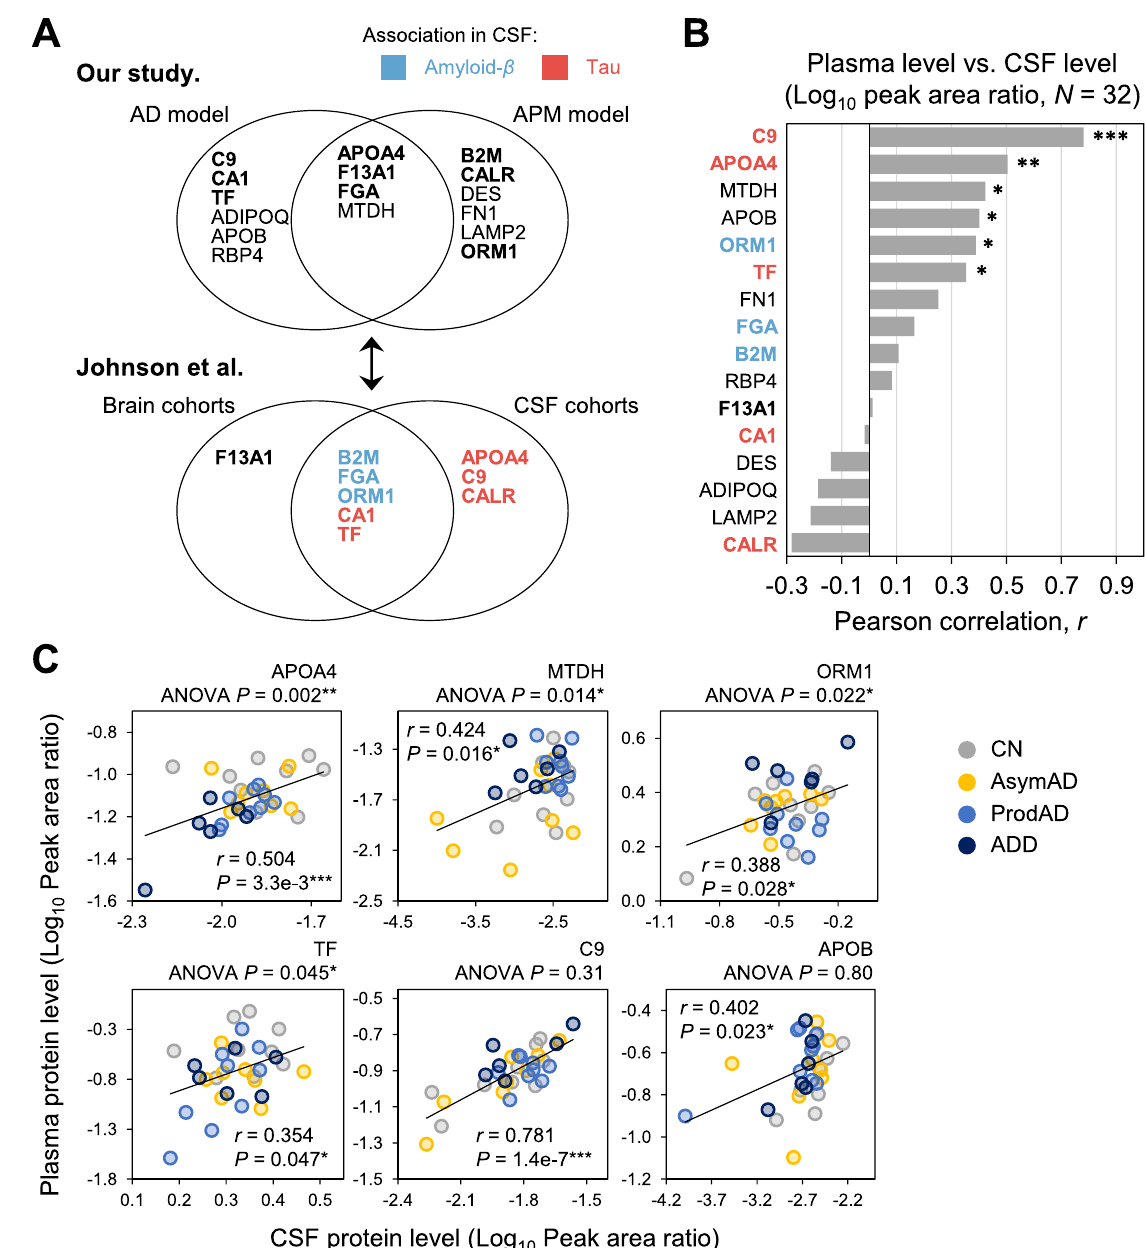
Figure 5. Association of plasma proteins with CSF proteins. ( a ) Correlation between Johnson et al. and our study. Between the AD and APM models, APOA4, F13A, FGA, and MTDH were selected by both as features, whereas C9, CA1, TF, APOB, RBP4, and ADIPOQ were unqiue to the AD model and CALR, B2M, LAMP2, DES, FN1, and ORM1 were unique to the APM model. Among 16 proteins, 9 were mentioned in Johson et al., in which B2M, FGA, and ORM1 were associated with amyloid and APOA4, C9, CALR, CA1, and TF were associated with tau. ( b ) Target correlation between CSF and plasma. Correlation of the 16 proteins among the 32 that matched in both CSF and plasma. Seven targets had Pearson’s correlation values above 0.3. ( c ) Scatter plot of 6 target proteins among the CSF and plasma